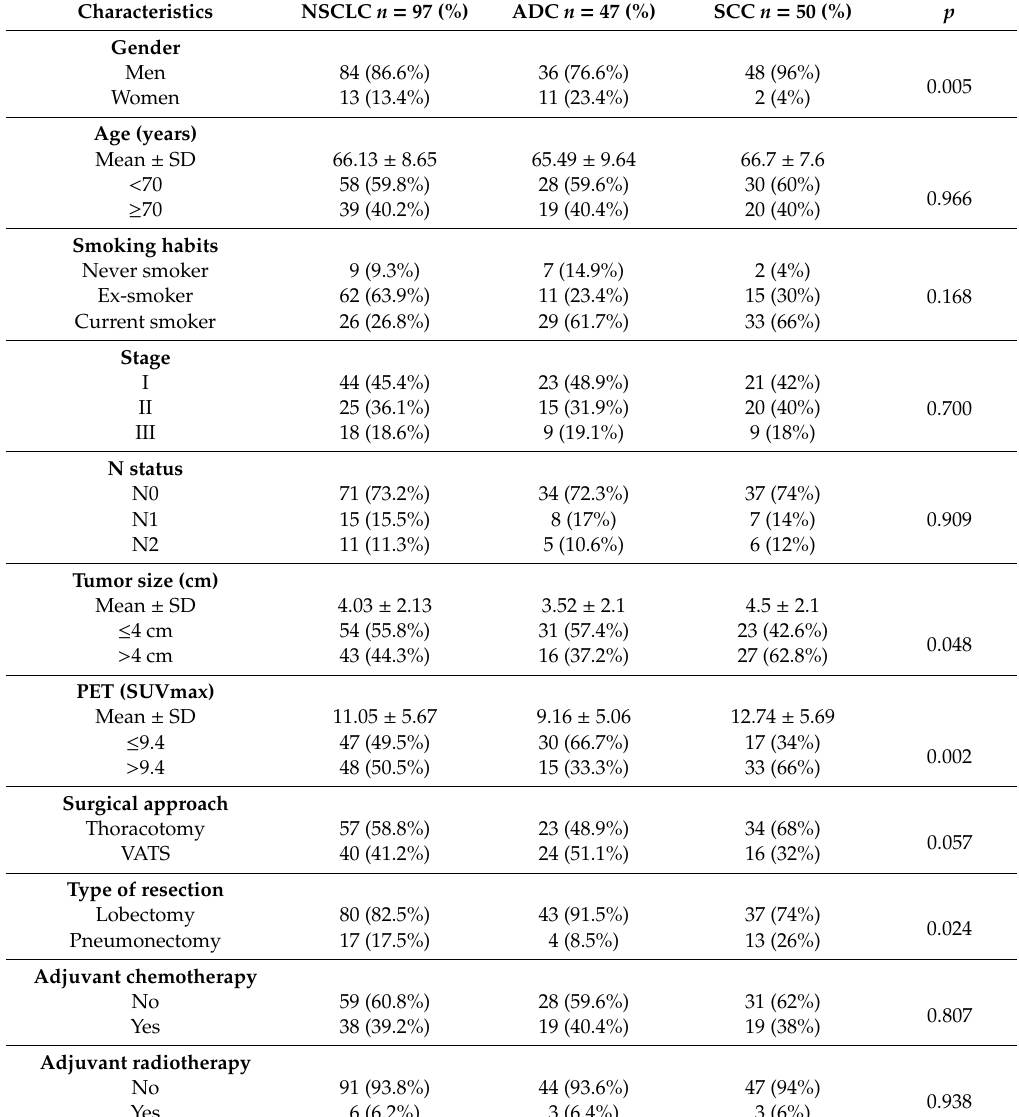
Clinical–pathological and treatment-related characteristics of NSCLC patients by histological